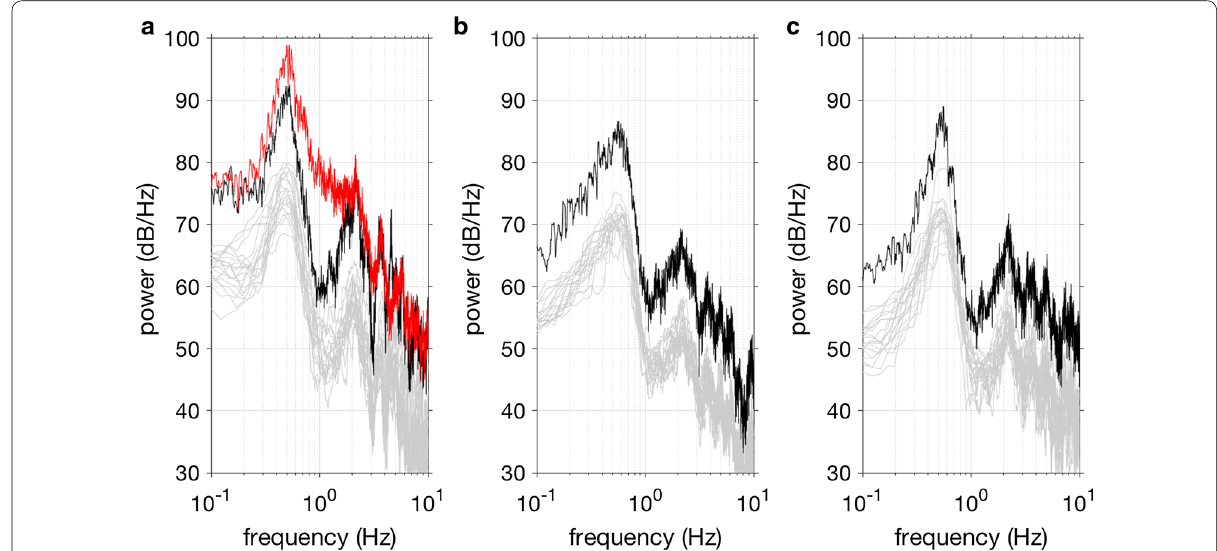
Fig. 4 Power spectra for Aso infrasound signals. Power spectra of a 10-min and 30-s records (black and gray lines, respectively) for the times of various surficial phenomena ( a Strombolian explosion; b ash ejection; and c emission of gas-steam mixtures). Same data of Fig. 2 are used to calculate the spectra. Red line in a is data on March 25, 2015, when the intense Strombolian explosions and gas exhalations were